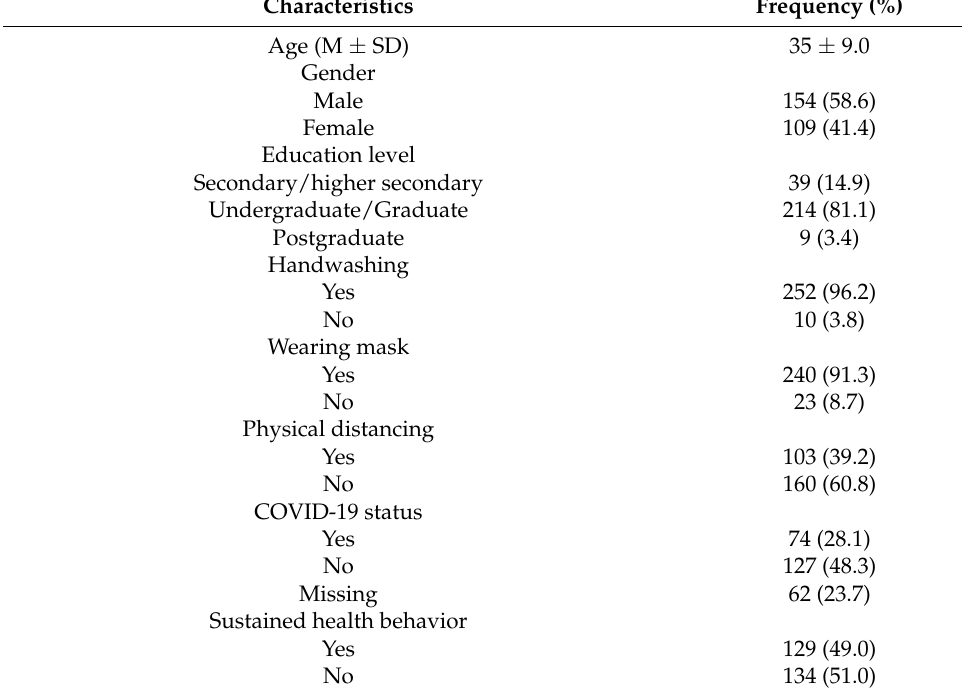
Table 1. Background characteristics of the study population ( n =